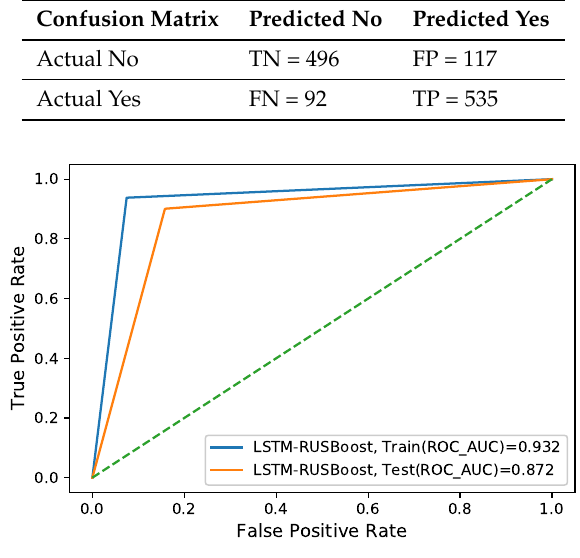
Figure 8. ROC-AUC of proposed model. Table 10. Mapping of problems addressed and validation